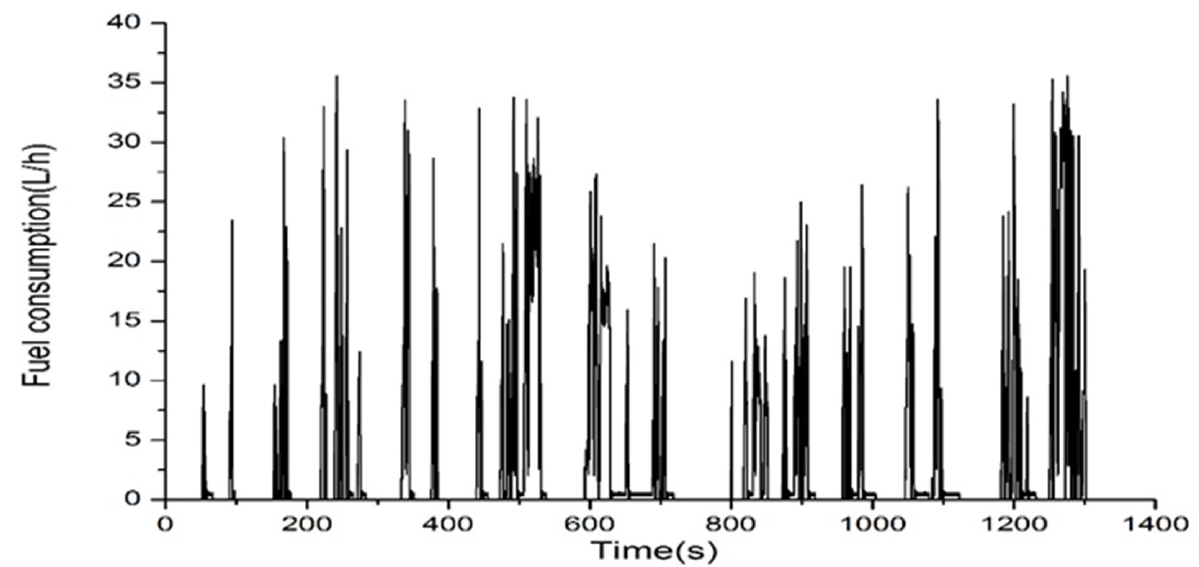
Figure 18. Instantaneous fuel consumption rate of engine.